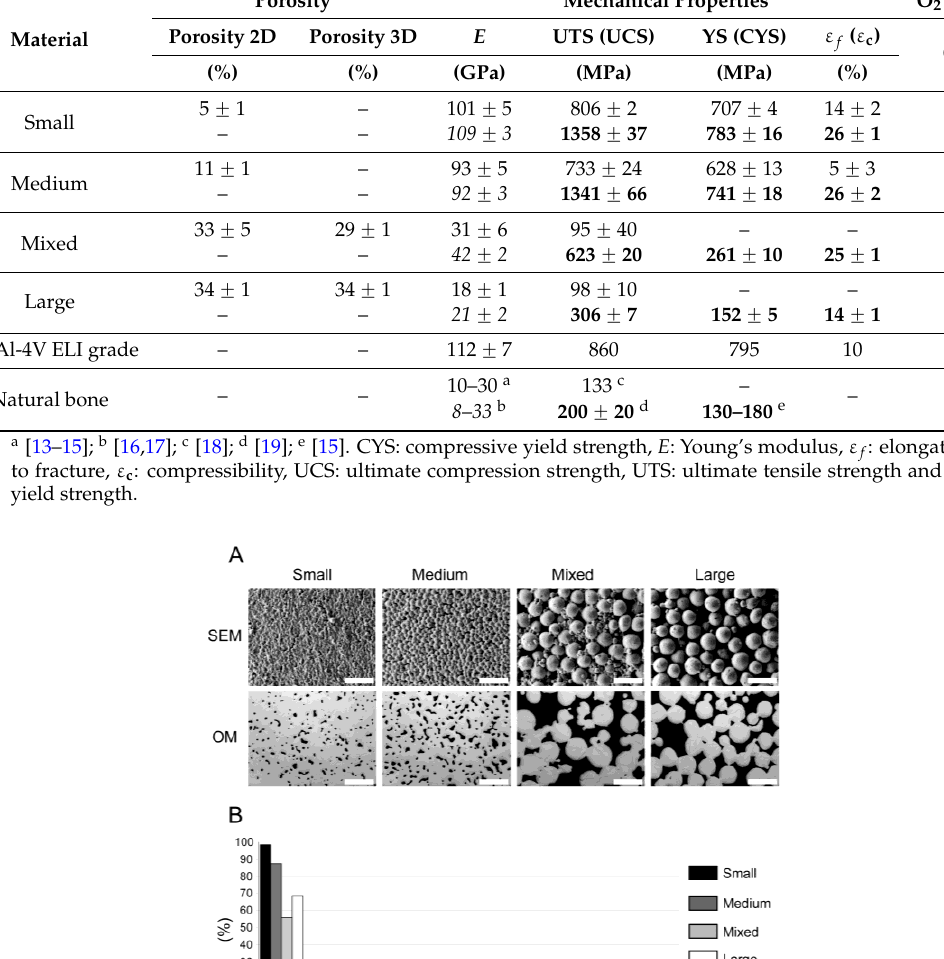
Table 1. Material properties, mechanical properties, pore volumes, and oxygen contents of the different porous Ti-6Al-4V materials (adapted from [11]). The results of tensile, compression, and resonant ultrasound spectroscopy (RUS) tests are displayed in Palatino Linotype, bold, and in italic font, respectively.